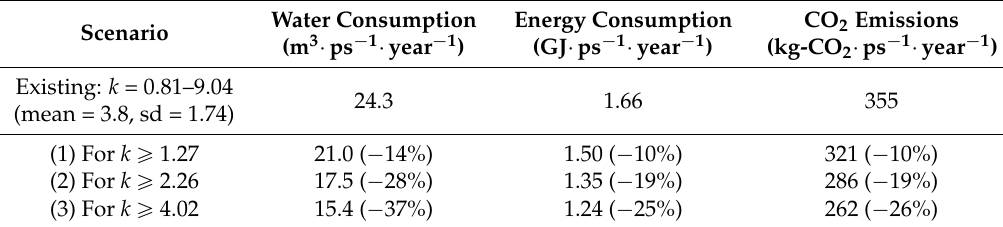
Table 7. Impacts of the Water Efficiency Labelling Scheme on showers for bathing in relation to water savings, energy savings and CO 2 emissions reductions.